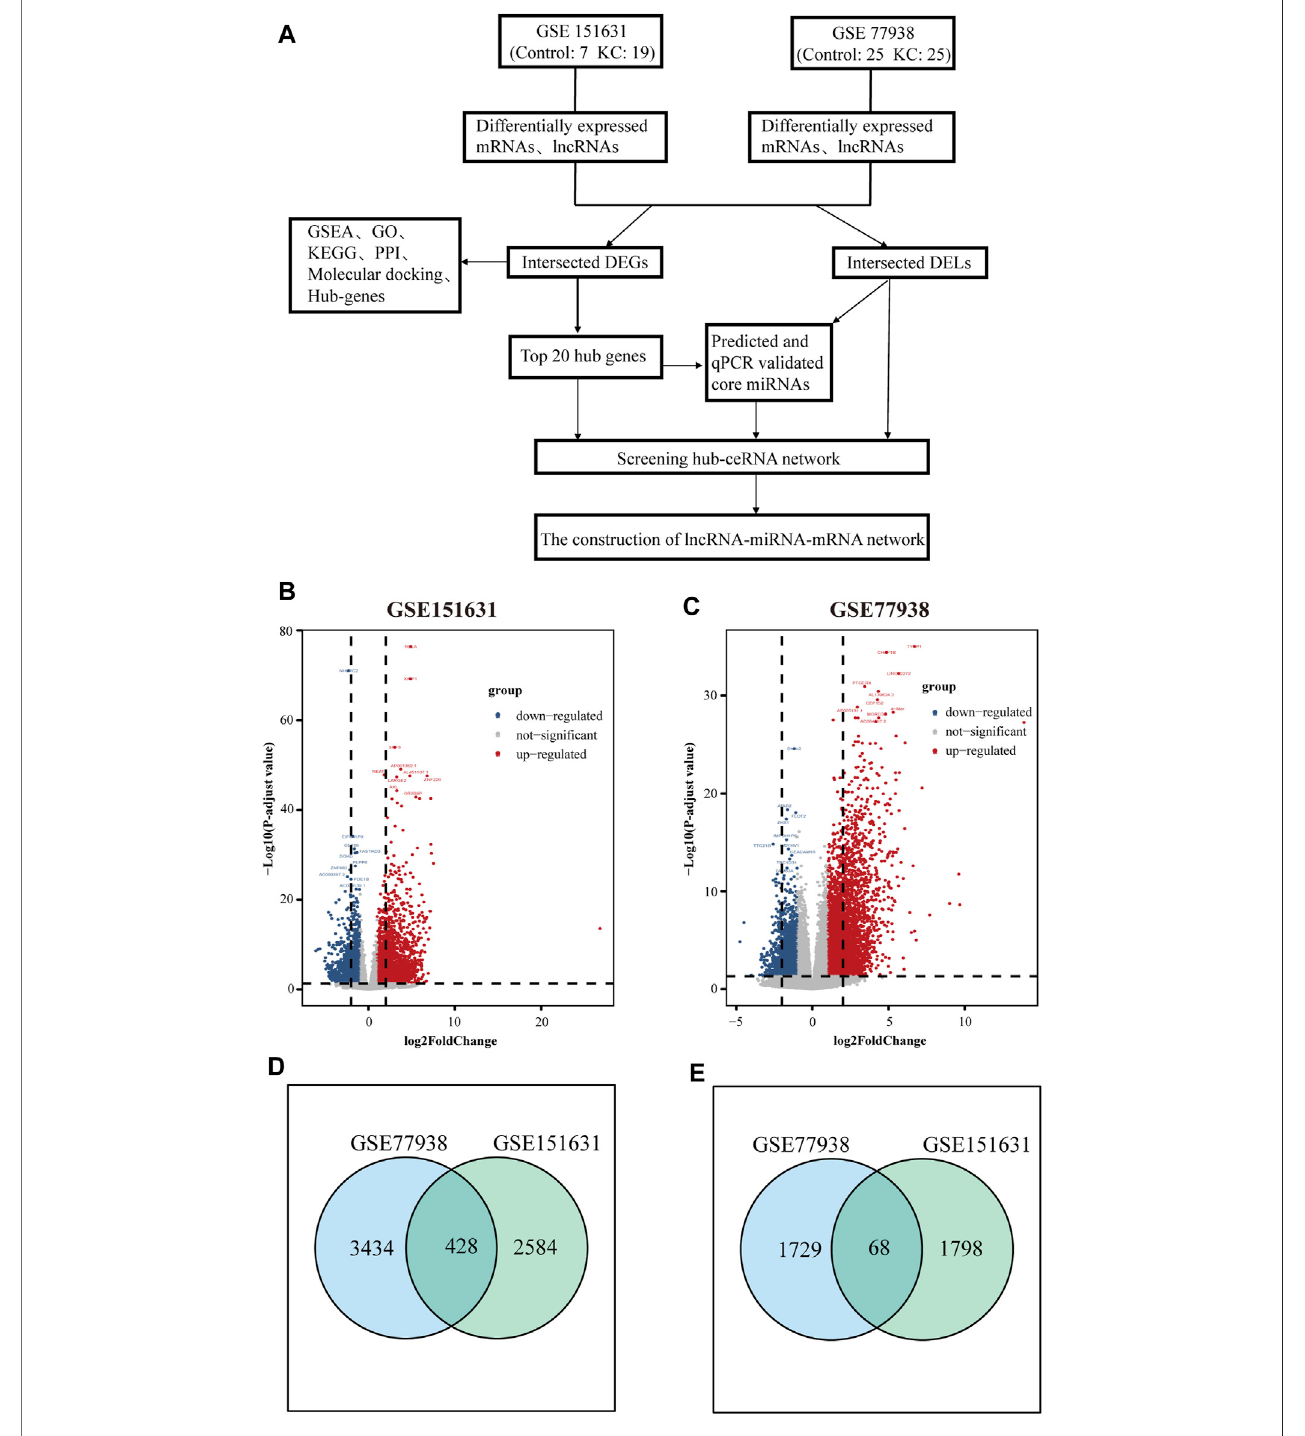
FIGURE 1 | Screening work fl ow and results of DEGs and DELs. (A) Flowchart of constructing the ceRNA network. (B) Volcano plot showing the DEGs and DELs identi fi ed from GSE151631. (C) Volcano plot showing the DEGs and DELs identi fi ed from GSE77938. Note: the gray dots represent genes with no signi fi cant changes, and the blue dots and red dots represent the downregulated and upregulated genes in KC samples, respectively. (D) Intersection of DEGs of GSE151631 and GSE77938 datasets. (E) Intersection of DELs of GSE151631 and GSE77938 datasets.